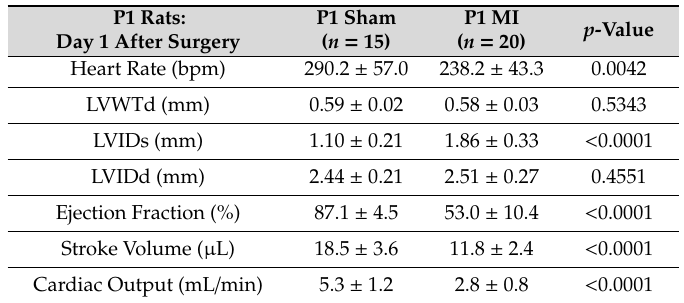
Table 1. Echocardiography assessment at Day 1 after surgery. P1 Rats: Day 1 After